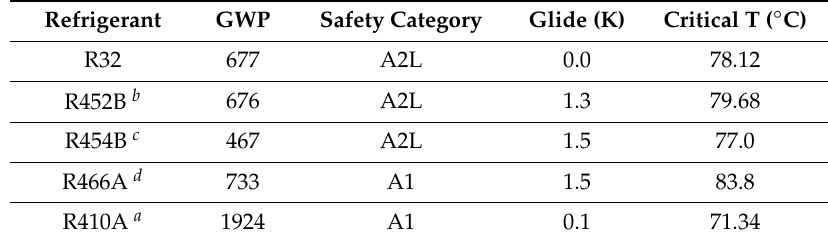
Table 1. Replacements for refrigerant R410A which have lower global warming potentials (GWPs) [22]. Refrigerant GWP Safety Category Glide